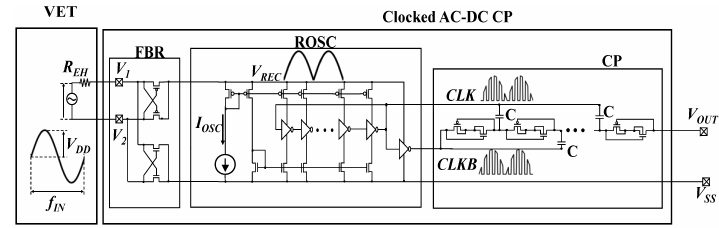
Figure 12. System diagram of the rectifier proposed in